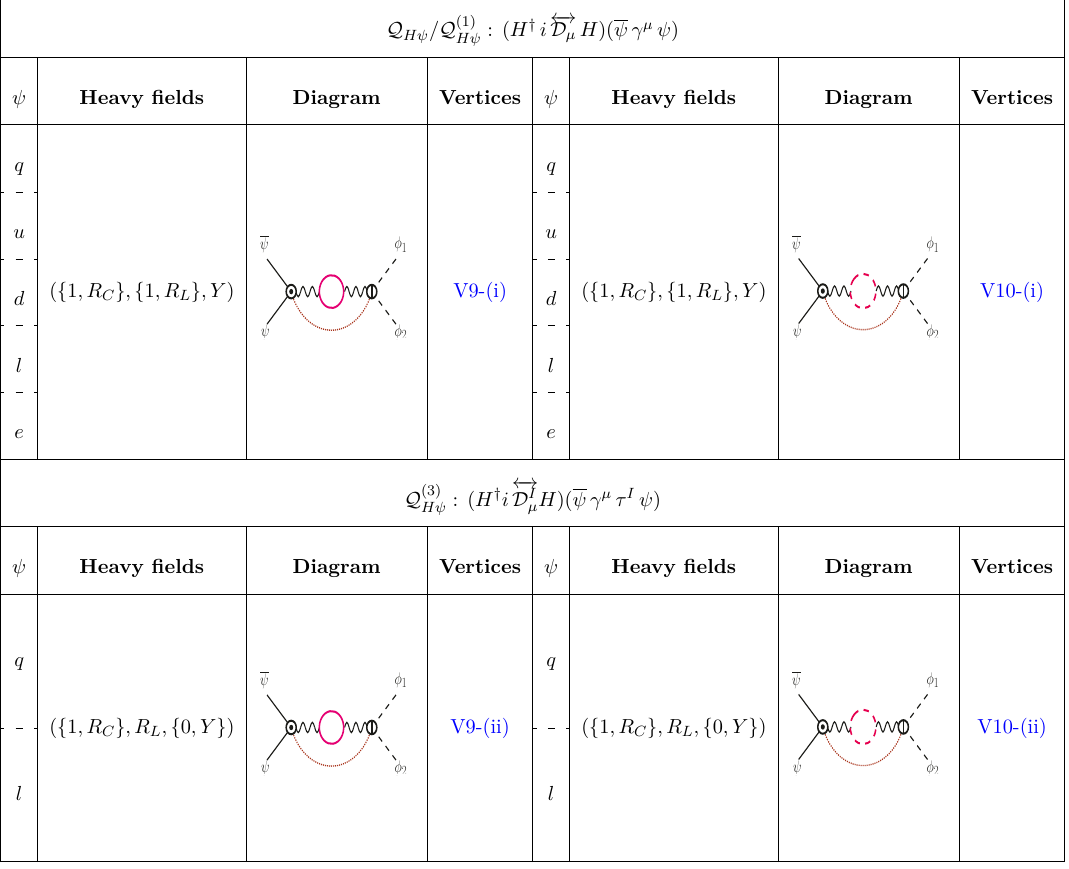
Table 9 . Heavy field representations that are obtained by unfolding the ψ 2 φ 2 D operators into non-trivial one-loop-level diagrams and the corresponding vertices. In each sub-table, operators with different fermions as external legs but leading to identical heavy field representations through similar diagrams have been grouped together. The headers schematically describe the covariant forms of the